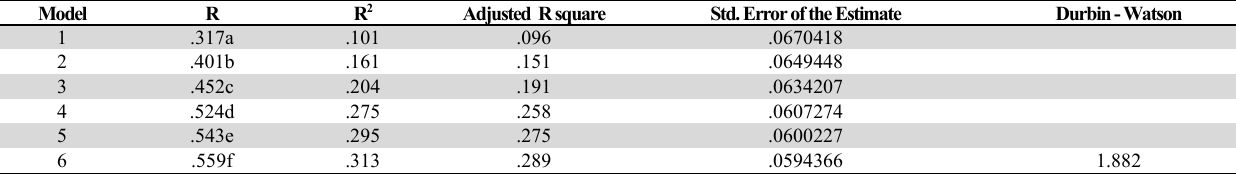
(Source: Results of running SPSS 22)